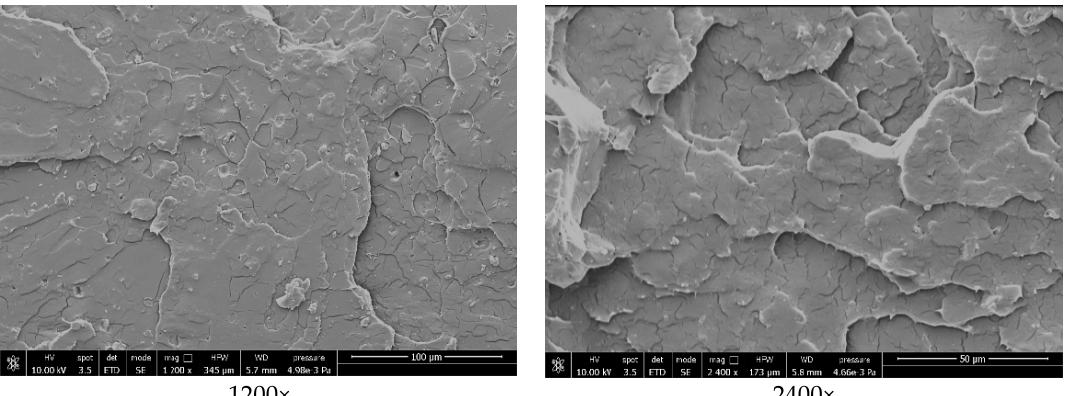
Figure 6. SEM images of the PLA based matrix at the indicated magnification.